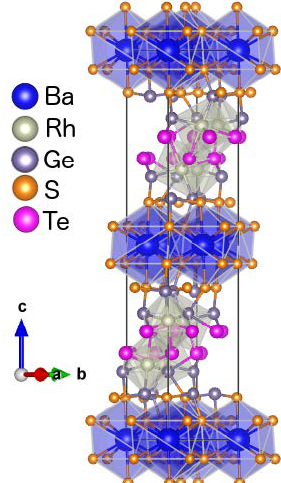
Figure 6. Crystal structure of BaRh 2 Ge 4 S 4 Te 2 . Barium atoms are big balls in blue, rhodium in grey, germanium in purple, sulphur in orange, selenium atoms are small balls in green, Te in magenta. The mixture of S and Te in the structure leads to a markedly di ff erent electronic band structure as can be seen in Figure 7. First, the bands are not as flat near the band edges as those of the single-type chalcogen compounds. Next, the valence band maximum (VBM) and the conduction band minimum (CBM) are shifted with respect to those of the previous compounds. The VBM is indistinguishably located between the Z → T and Γ → Y symmetry lines and the CBM expands along the Γ → Z line. Hence, the electronic gap is indirect and is estimated to be 0.71 eV. This value is intermediate between that of BaRh 2 Ge 4 Se 6 and that of BaRh 2 Ge 4 Te 6 . As with the previous compounds, the relativistic e ff ects are negligible. The orbital-projected DOS show that the main contributions near the Fermi level arise from the p orbitals of the chalcogen atoms and from the germanium ones (Figure 8). It is noticeable that the Te contribution is particularly important compared to that of